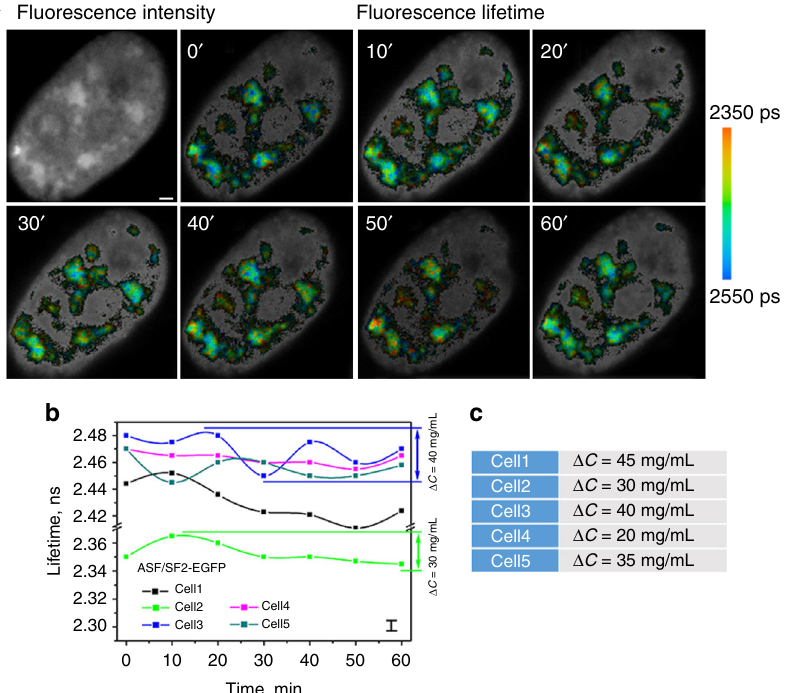
Fig. 2 Cyclic changes in absolute concentrations of proteins in nuclear speckles. a Fluorescence intensity image (upper left) and fl uorescence lifetime images, of a live cultured cell expressing ASF/SF2-EGFP. Images were acquired with 10 min intervals. Scale bar is 1 μ m. b Fluorescence lifetime changes in the nuclear speckles of single cells. Corresponding changes in absolute protein concentrations in the nuclear speckles for two representative cells are shown on the right y -axis. Error bar in the bottom right corner shows the instrument measurement error. c Protein concentration changes ( Δ C ) per